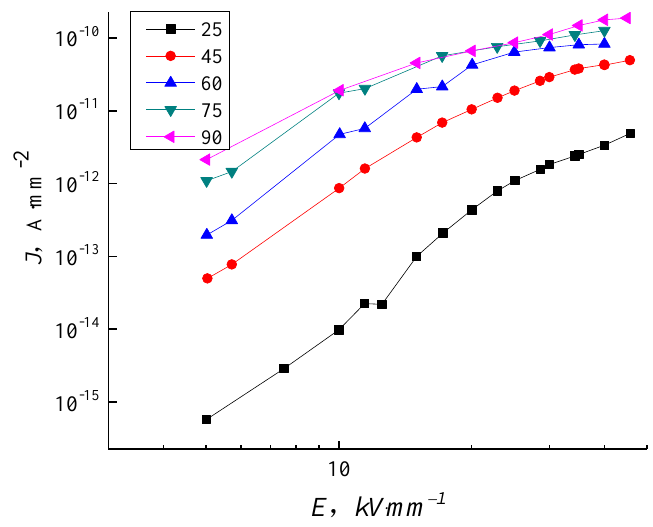
Figure 8. J-E characteristic curve of LDPE in different temperatures.